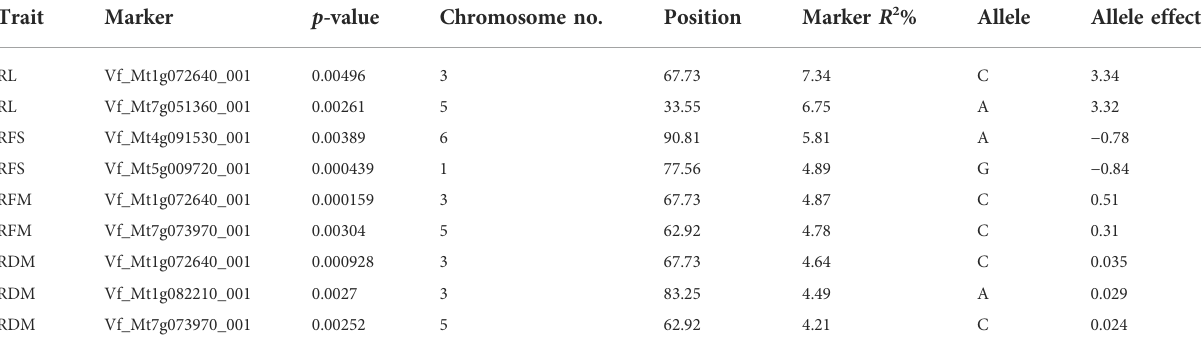
TABLE 2 List of signi fi cant SNPs associated with root traits using the GLM model including the p -value, chromosome number, phenotypic variation, target allele, and allele effect. Trait Marker p -value Chromosome no. Position Marker R 2 % Allele Allele